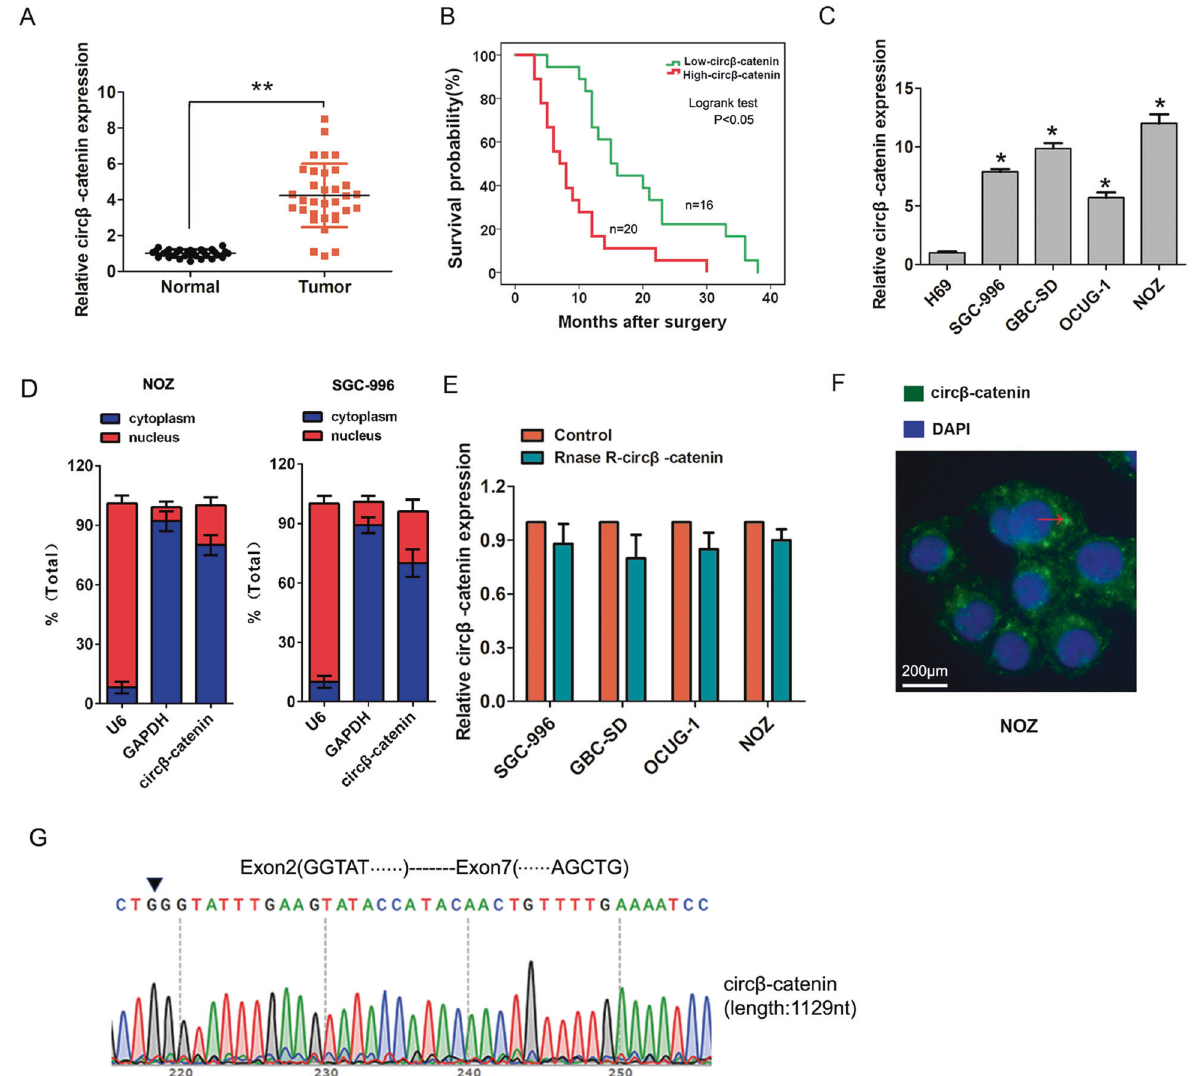
Fig. 1 The circ β -catenin expression is upregulated in GBC tissues and cells. A The relative expression of circ β -catenin in gallbladder cancer tissues and adjacent normal tissues was detected by qRT-PCR analysis. B The correlation between the expression of circ β -catenin and over survival (OS) of GBC patients analyzed by the Kaplan – Meier method and log-rank test. C the relative expression of circ β -catenin in GBC cells (GBC-SD, SGC-996, NOZ, and OCUG-1) and H69 cell was determined by qRT-PCR analysis. D The expression of circ β -catenin was assessed by qRT-PCR in the nuclear and cytoplasm fractions in NOZ or SGC-996 cell lines. E RNase R was used to pretreat the RNAs and we found that the circular form of circ β -catenin was resistant to RNase R in four GBC cell lines compared with control group. F The subcellular localization of circ β -catenin detected by FISH assay. G RNA was isolated and RT-PCR with Sanger sequencing con fi rmed the circular form in NOZ cells and comes from exon regions. Data are shown as mean ± SD. * P < 0.05, ** P < analysis. Our results found that circ β -catenin expression was markedly upregulated in human GBC tissues compared to adjacent normal tissues (Fig. 1A). Furthermore, we divided the GBC patients into two groups (higher circ β -catenin expression or lower circ β -catenin expression) according to the median expres- sion of circ β -catenin in GBC tissues. Statistical analysis demon- strated that increased expression of circ β -catenin was signi fi cantly associated with advanced TNM stage (Table 1, P = 0.021), but no association with other clinicopathological characteristics (Table 1, P > 0.05). Moreover, Kaplan – Meier survival curve and log-rank test showed that GBC patients with higher expression of circ β -catenin have signi fi cantly shorter overall survival (OS) than those with the lower expression of circ β -catenin (Fig. 1B, log-rank test, P < 0.05). Multivariate Cox survival analysis also showed that higher circ β -catenin expression (hazard ratio [HR] = 2.577, 95%